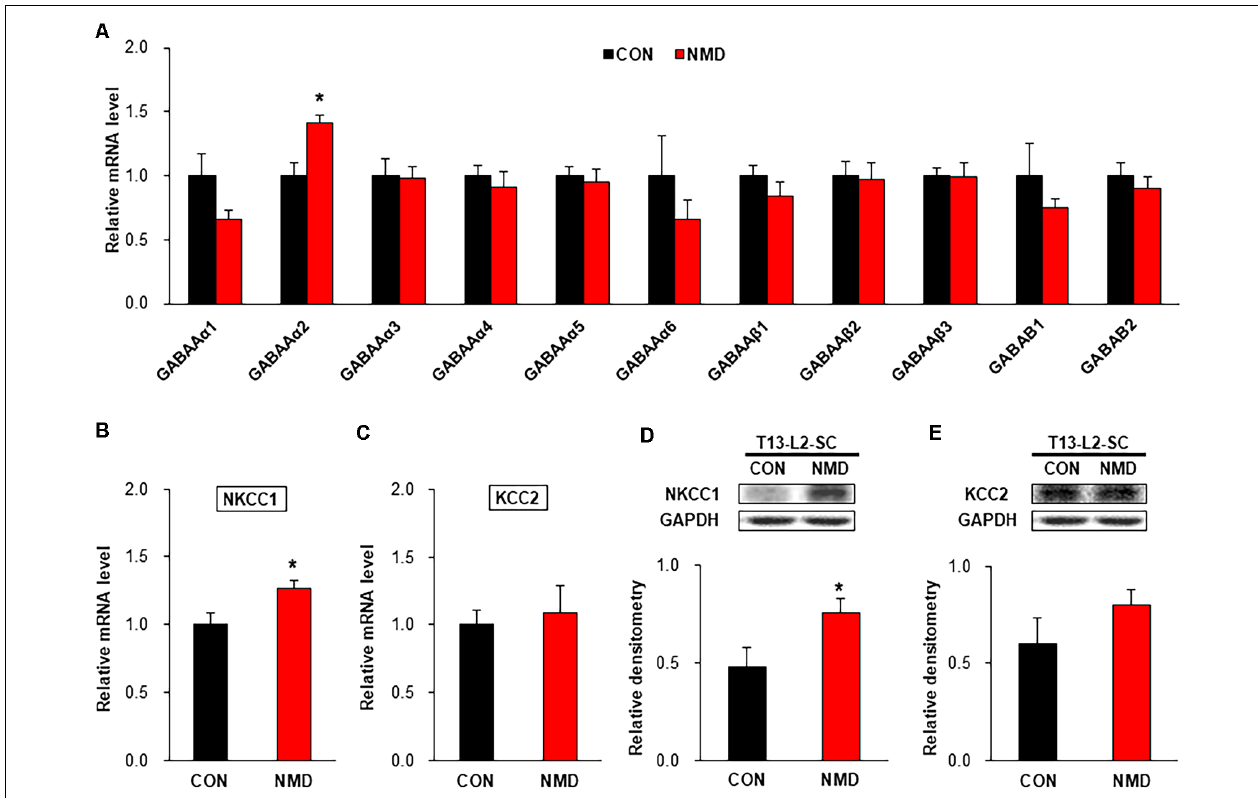
FIGURE 5 | NMD enhanced sodium-potassium chloride cotransporter 1 (NKCC1) expression. (A) The mRNA level of GABA receptors in the spinal dorsal horn of T13-L2 in NMD rats compared with CON rats (* P < 0.05, n = 4 rats for each group, two-sample t -test). (B) The mRNA level of NKCC1 in the spinal dorsal horn of T13-L2 in NMD rats compared with CON rats (* P < 0.05, n = 4 rats for each group, two-sample t -test). (C) The mRNA level of KCC2 in the spinal dorsal horn of T13-L2 in NMD rats compared with CON rats ( P > 0.05, n = 4 rats for each group, two-sample t -test). (D) Expression of NKCC1 in the spinal dorsal horn of T13-L2 in NMD rats compared with CON rats (* P < 0.05, n = 6 rats for each group, two-sample t -test). (E) Expression of KCC2 in the spinal dorsal horn of T13-L2 in NMD rats compared with CON rats ( P > 0.05, n = 6 rats for each group, two-sample t -test).